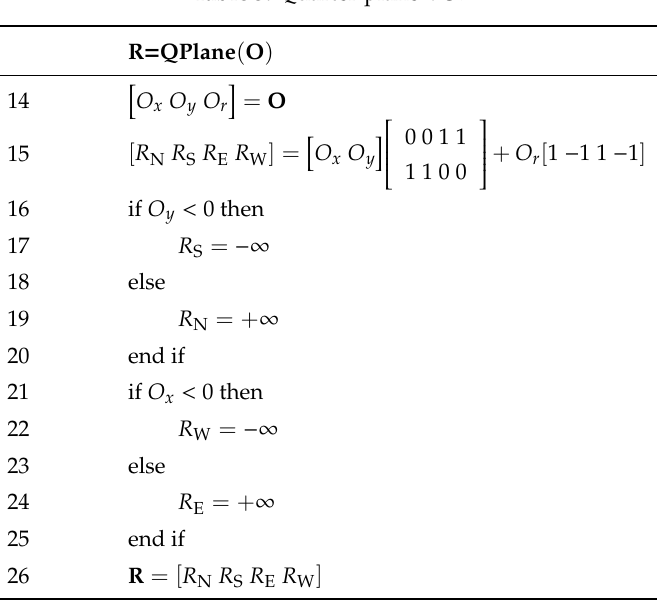
Table 3. Quarter-plane